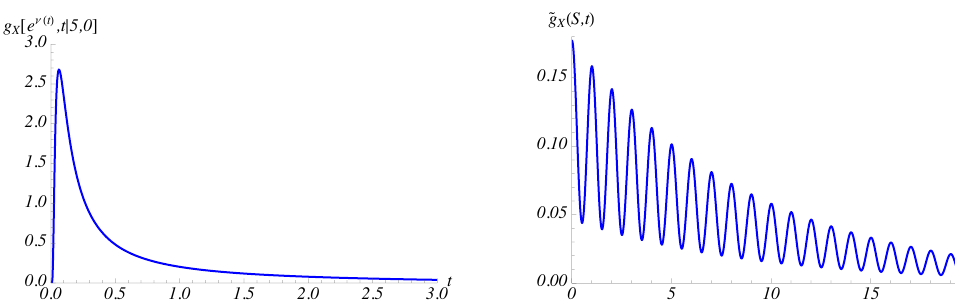
Figure 3. The FPT density through the carrying capacity S 1 ( t ) = e ν ( t ) = e + 0.3 sin ( 2 π t ) is plotted on the left for the same choices as Figure 1, with x 0 = 5 and σ 2 = 2. On the right, the asymptotic behavior of the FPT pdf through S = 20 is shown.